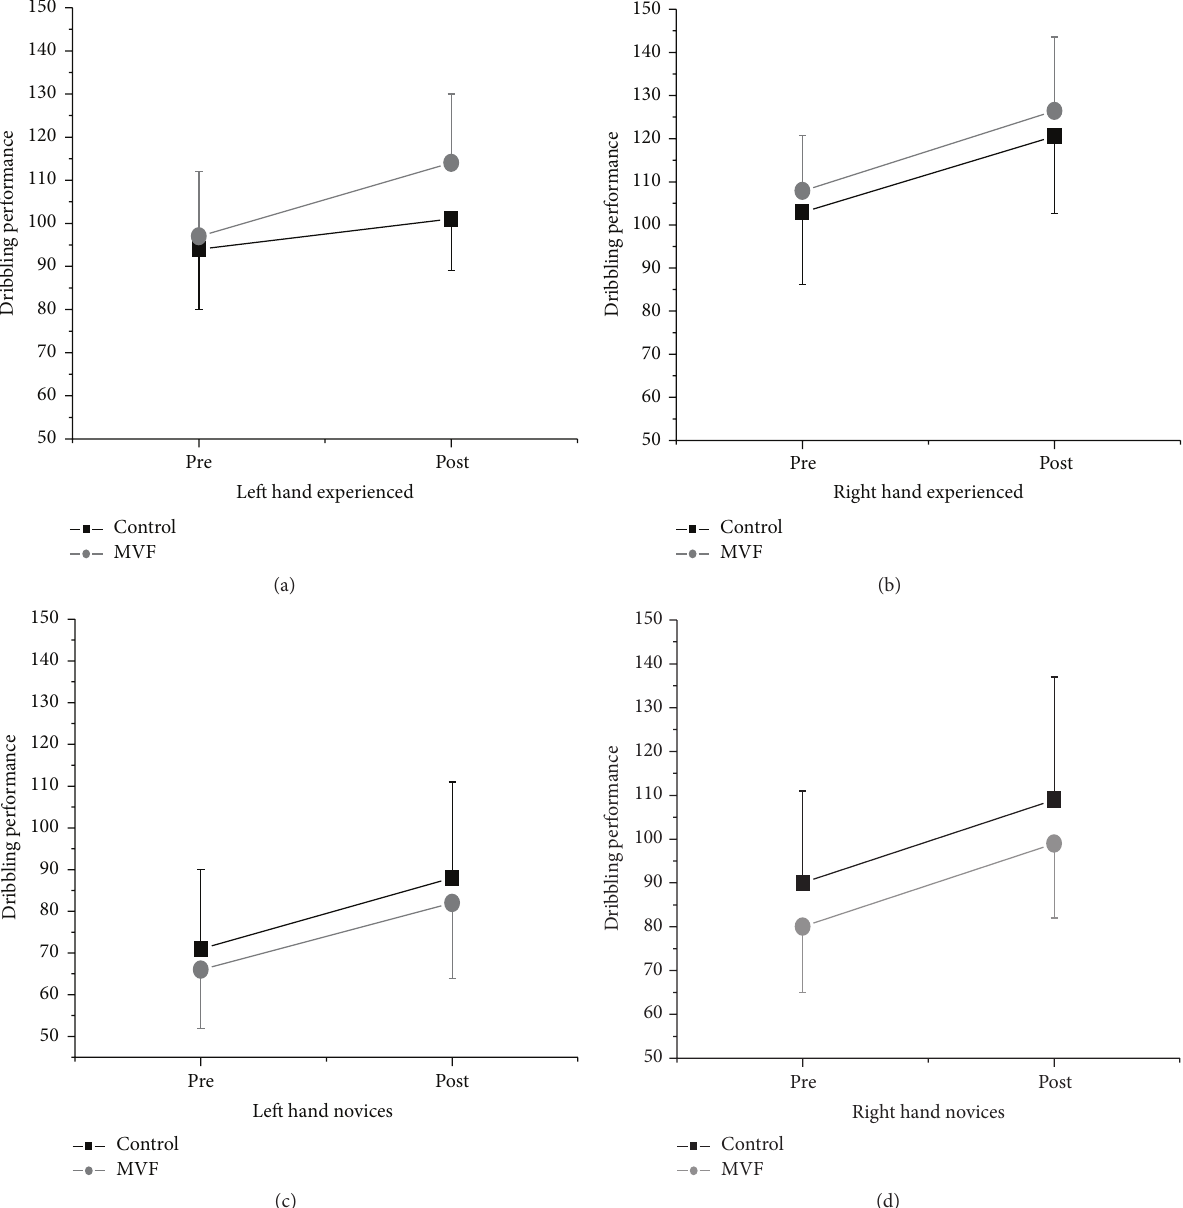
For a complete overview of test results, right hand perfor- mance improvements are shown in Figure